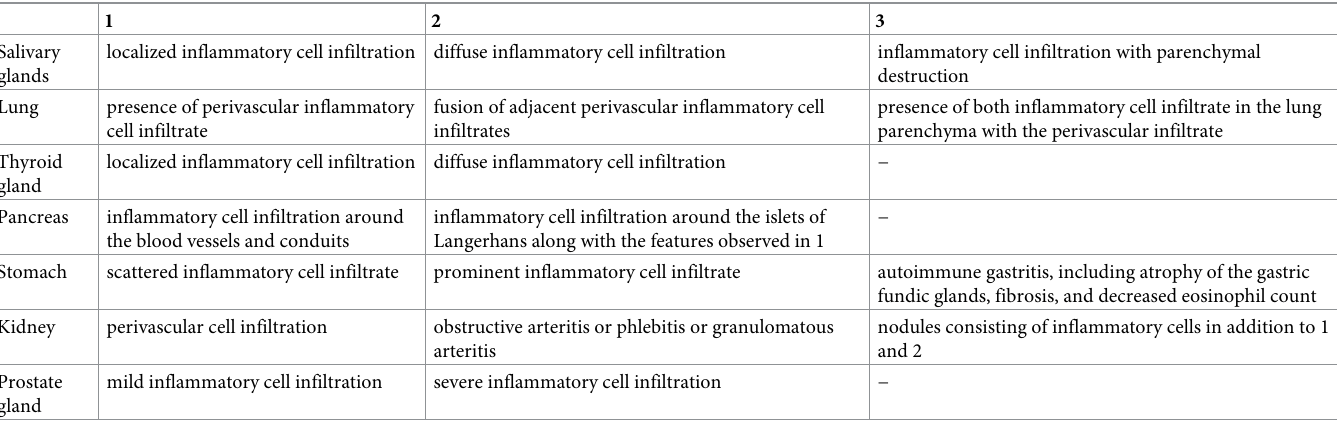
Table 2. Severity scaling of hematoxylin and eosin (H&E)-stained tissue